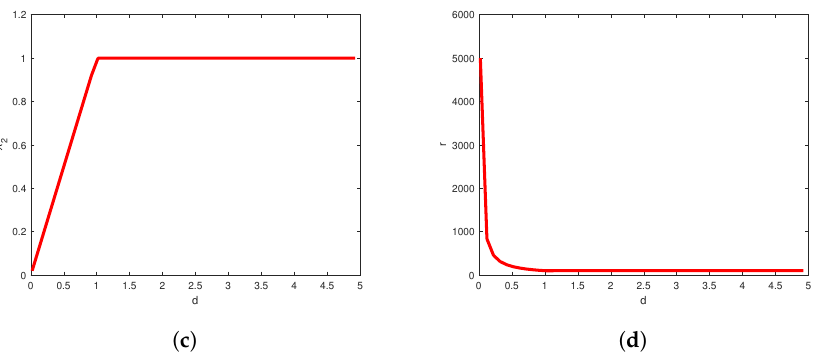
Figure 8. The synchronizability of Networks-C. Panel ( a ) depicts λ 2 vs. a and ( b ) depicts r vs. a when η = 100, d = 1, M = 2; Panel ( c ) depicts λ 2 vs. d and ( d ) depicts r vs. d when η = 100, a = 1, M = 2.